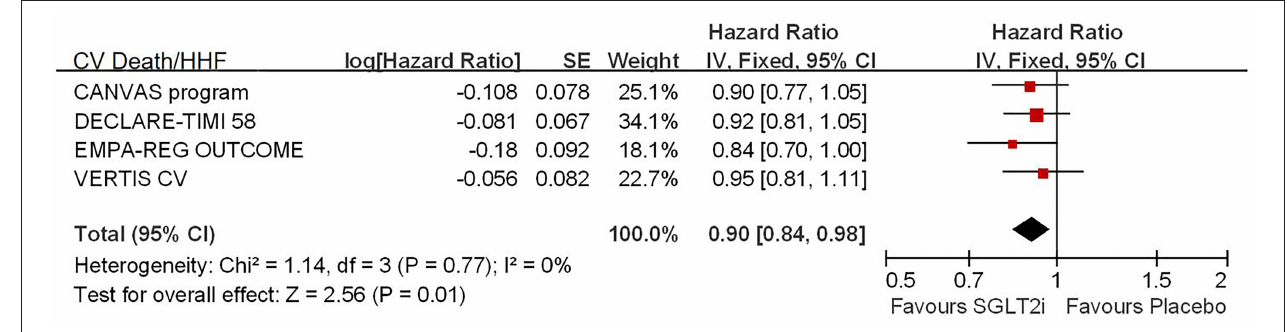
FIGURE 1 | Meta-analysis of SGLT2i on CV death or HHF.